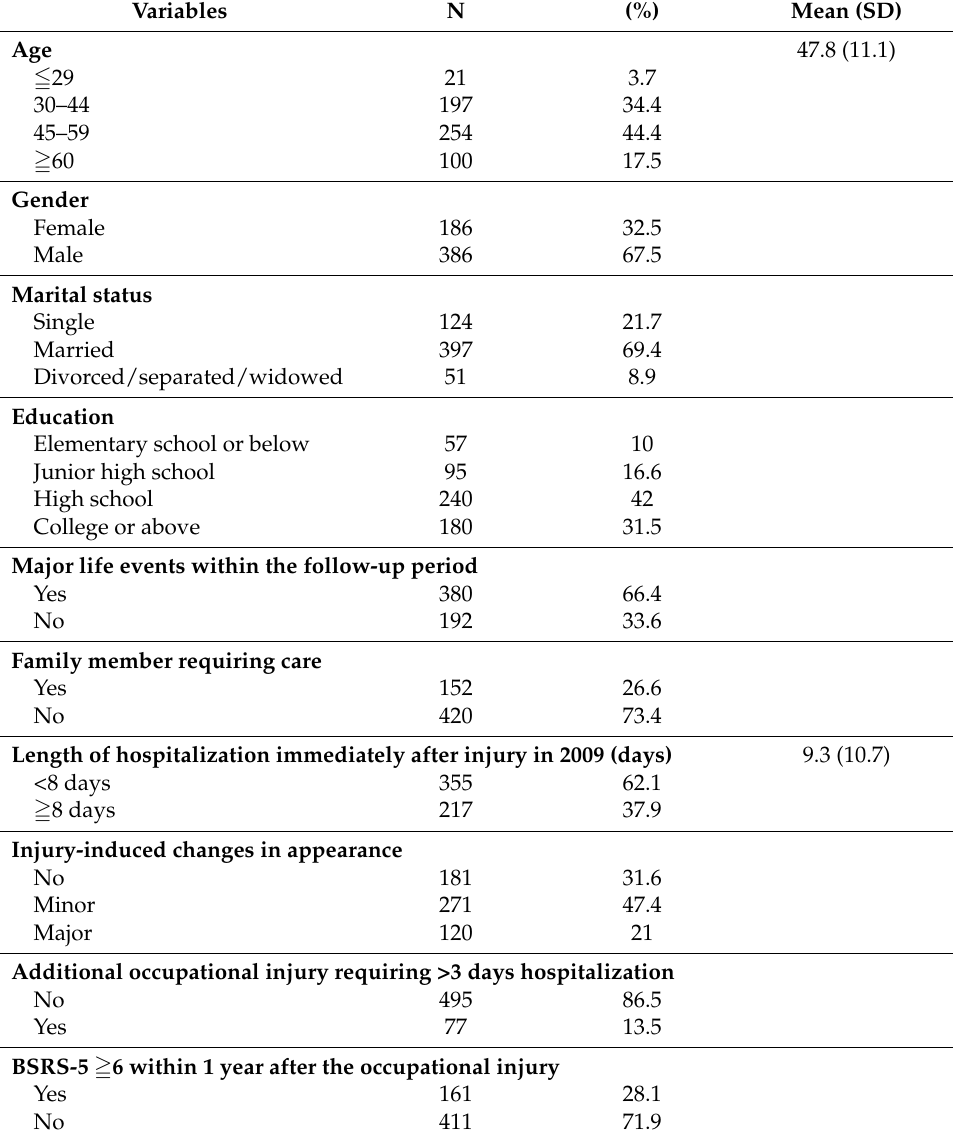
Table 1. Characteristics of workers with occupational injury ( n =